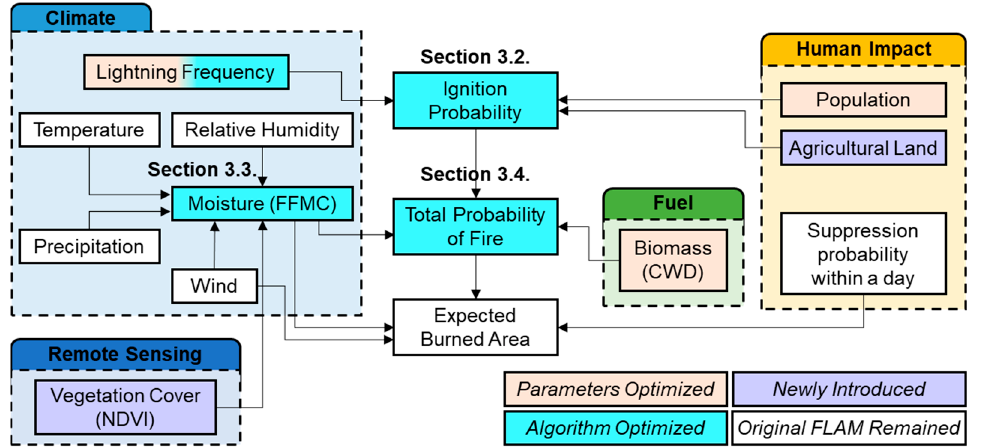
Figure 2. Architecture of the FLAM model. The indicated sections correspond to the section of the paper where each part of the model is explained: Section 3.2 for ignition probability, Section 3.3 for fuel moisture content calculation, and Section 3.4 for probability of fire. Each component of the flowchart is colored according to its improvement from the original FLAM, as indicated by the legend at the bottom right.